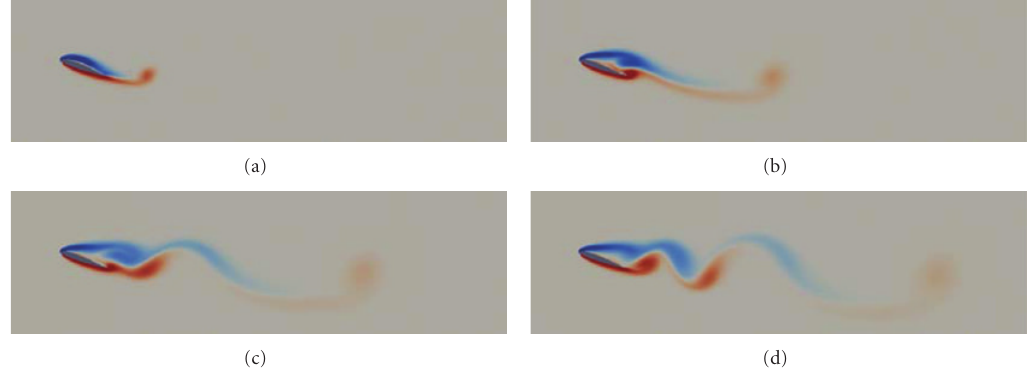
Figure 18: Vorticity plots of Re = 400 when M = 1 for t = 1 . 9 (a), 6.3 (b), 10.7 (c), and 12.9 (d).